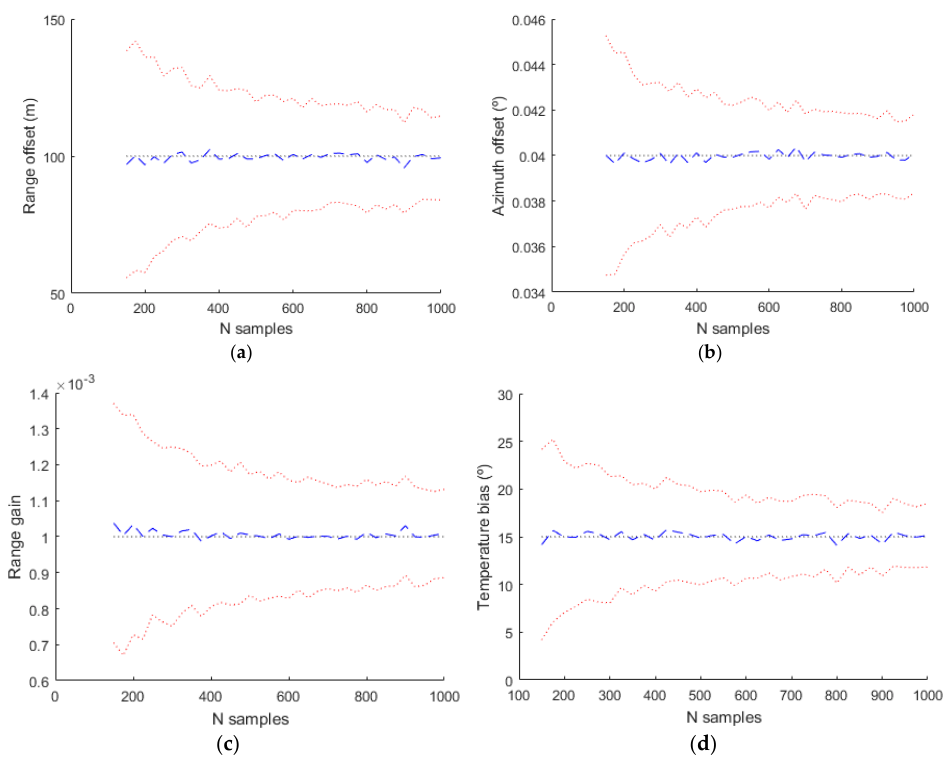
Figure 15. Estimated bias values for Radar 1 using the complete model. ( a ) Range offset; ( b ) Azimuth offset; ( c ) Range gain; ( d ) Temperature bias.